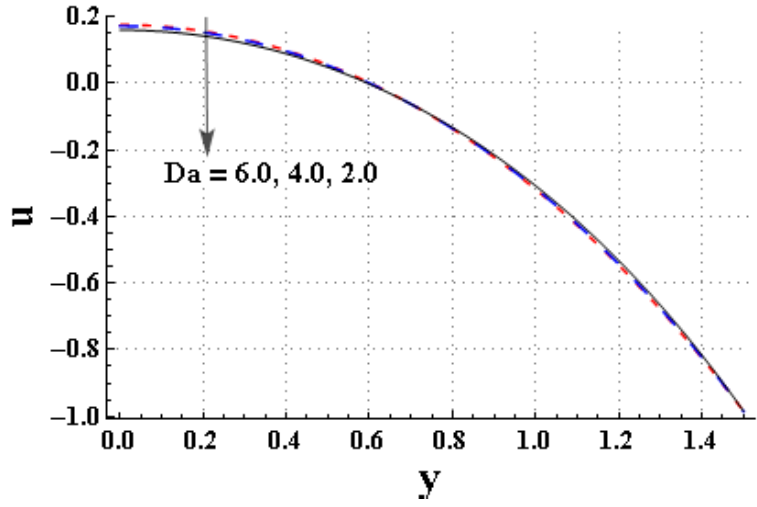
Figure 3. Effect of the Darcy parameter, Da , on velocity, u.